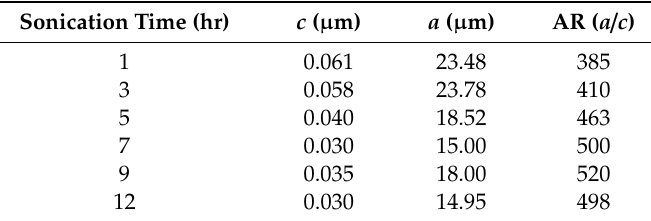
Table 9. a , c , AR values for sample M X2C2 ( d = 51